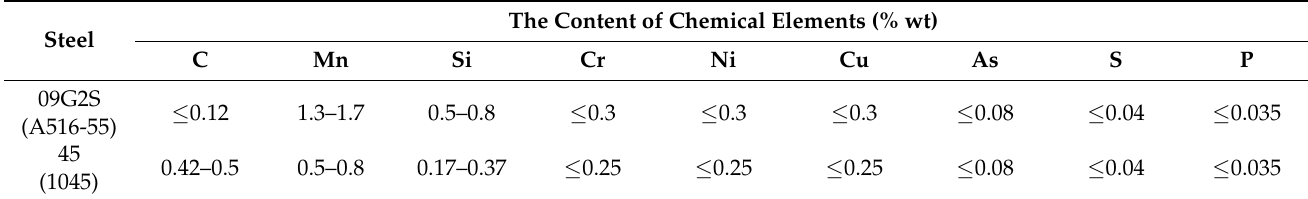
Table 1. The chemical composition of the studied